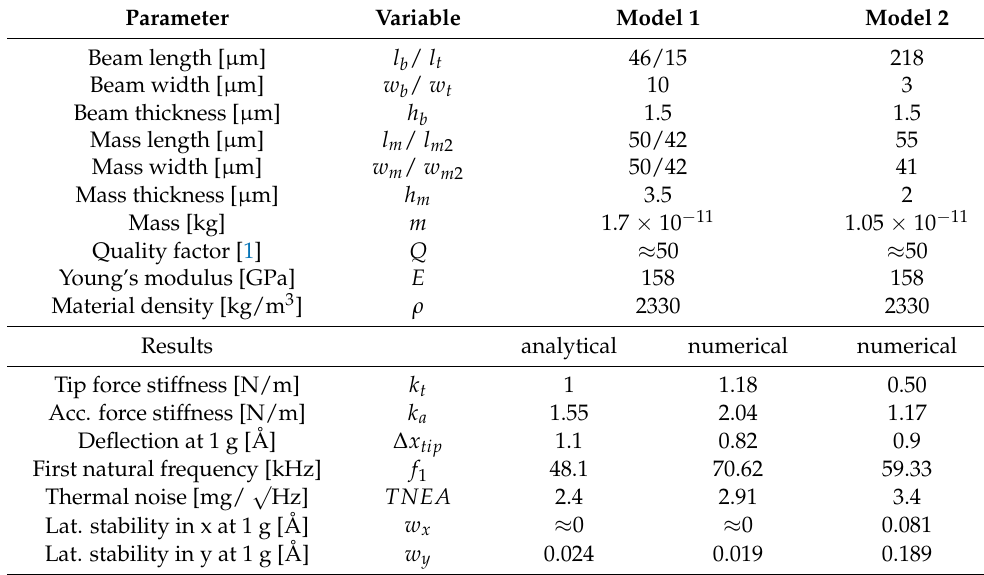
Table 3. Mechanical parameters of the sensor